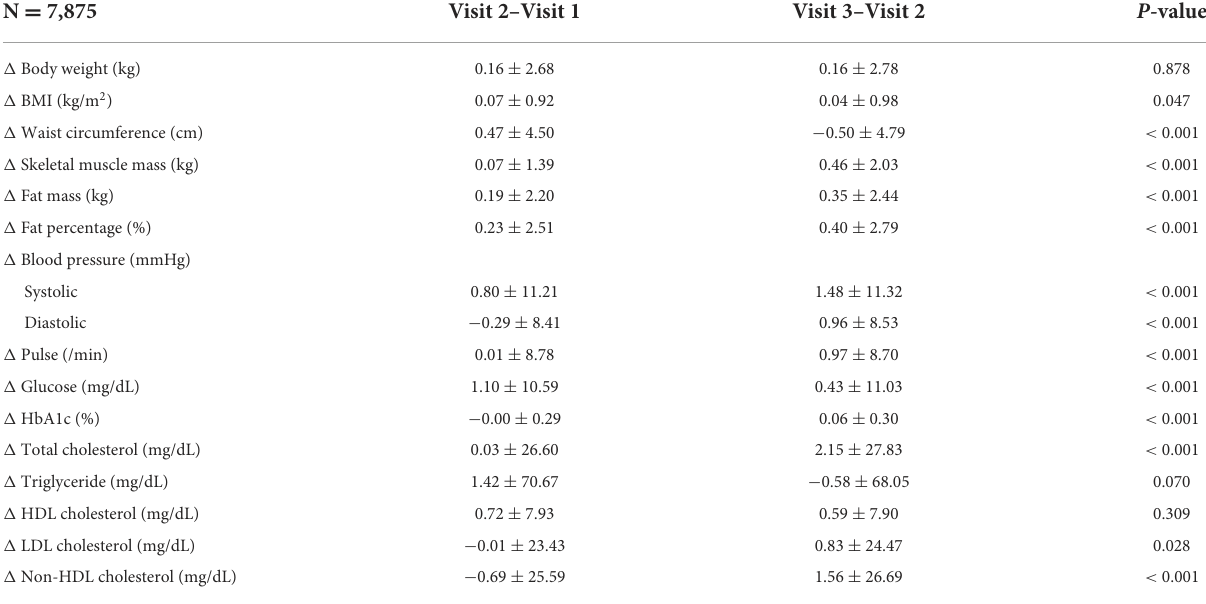
TABLE 2 Changes in obesity indices and metabolic markers at each visit.